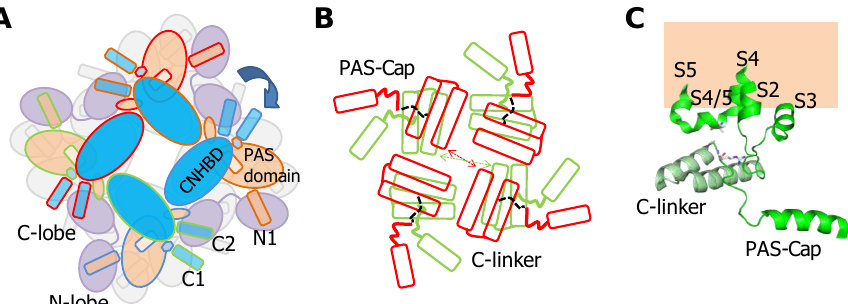
Figure 3. Movements during gating of Eag channels. ( A ). Realistic representation of the rigid body torsion of the intracellular cytoplasmic based on the structure of the closed Eag1 channel and the opened hERG channel, viewed from the bottom. ( B ). Realistic representation of the relative motion of the C-linker (joined rectangles representing antiparallel alpha helices) and the PAS-Cap. The dashed black line represents the presumed position of the N-terminus not seen in the cryo-EM images. ( C ). Structure of the C-linker and PAS-cap from opened hERG (PDB 5VA1). Arg 4 (corresponding to Arg 7) and Asp 540 (corresponding to Asp 342) are represented as stick using CPU coloring scheme. The orange box indicates the presumed position of the border of the